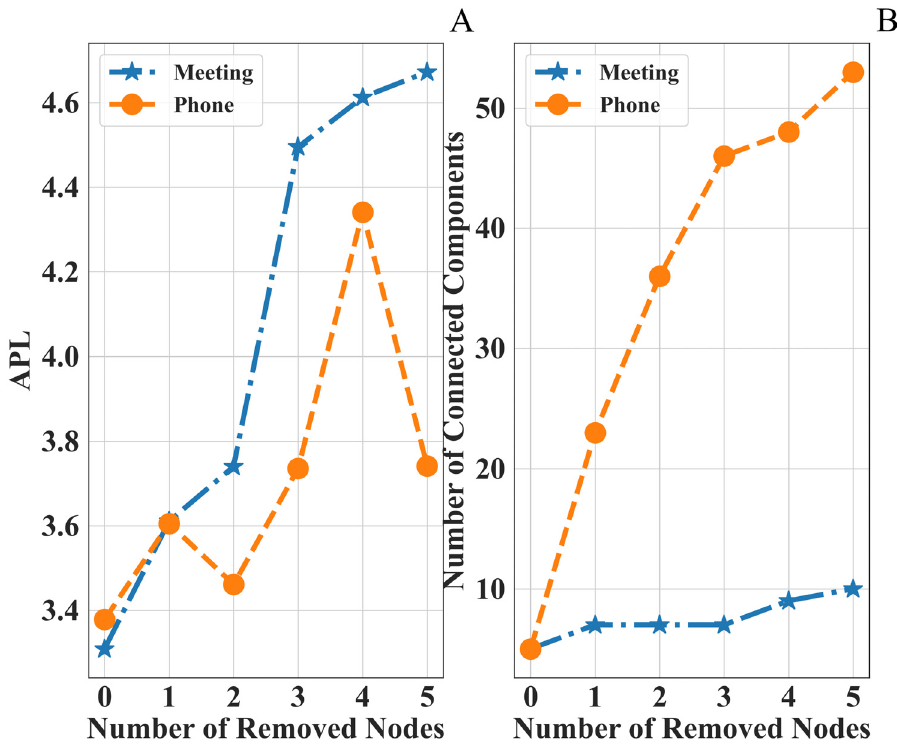
Fig 3. Function variations of the number of removed nodes in the Meetings and phone calls networks. Nodes are prioritized on the basis of their Betweenness centrality. A: Variation of the APL. B: Variation of the number of connected